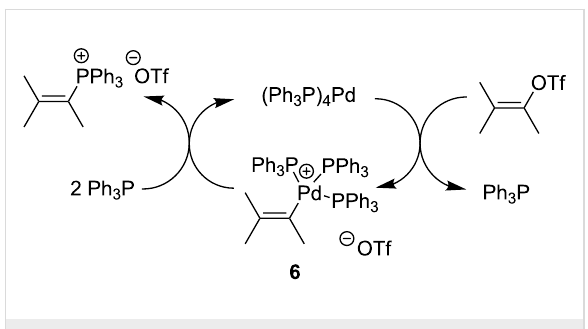
Scheme 7: Mechanism of alkylation of triphenylphosphine with vinyl triflates in the presence of (Ph 3 P) 4 Pd as